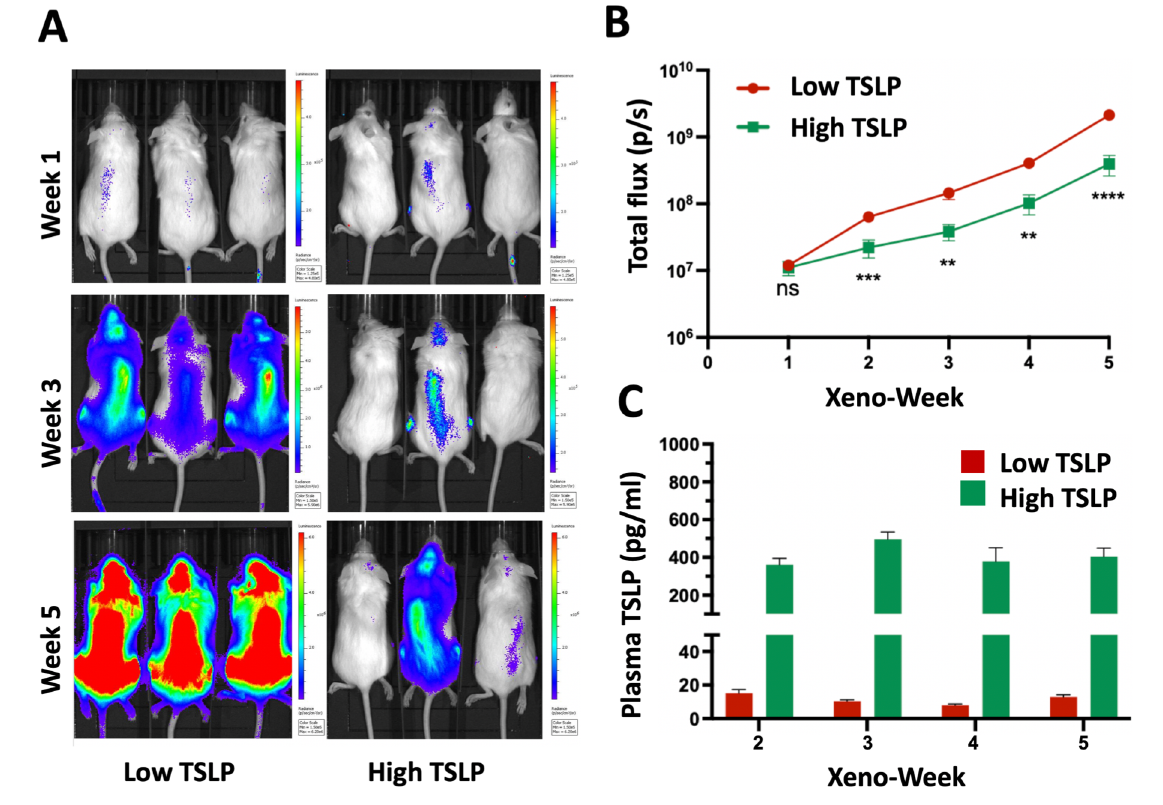
Figure 2. High TSLP doses reduced leukemia burden in Mutz-5-luc xenografts in vivo. In vivo imaging system (IVIS) images shown over time for Mutz-5-GFP xenografts with TSLP treatment starting 1 week after transplantation. Data are summarized as mean +/ − SEM. ( A ) Representative IVIS images of xenograft mice over time for low TSLP (1 × 10 5 TSLP-stroma cells/mouse/week) and high TSLP (10 × 10 6 TSLP-stroma cells/mouse/week) groups. ( B ) Graph showing the difference in leukemia burden between the low-TSLP and high-TSLP groups over time. Data were collected as total photon flux (photons per second). n = 22 (11 low-TSLP- and 11 high-TSLP-treated mice). ( C ) Plasma-TSLP levels in low- vs. high-TSLP mice over time. ** p < 0.01, *** p < 0.001, **** p < 0.0001, ns = not